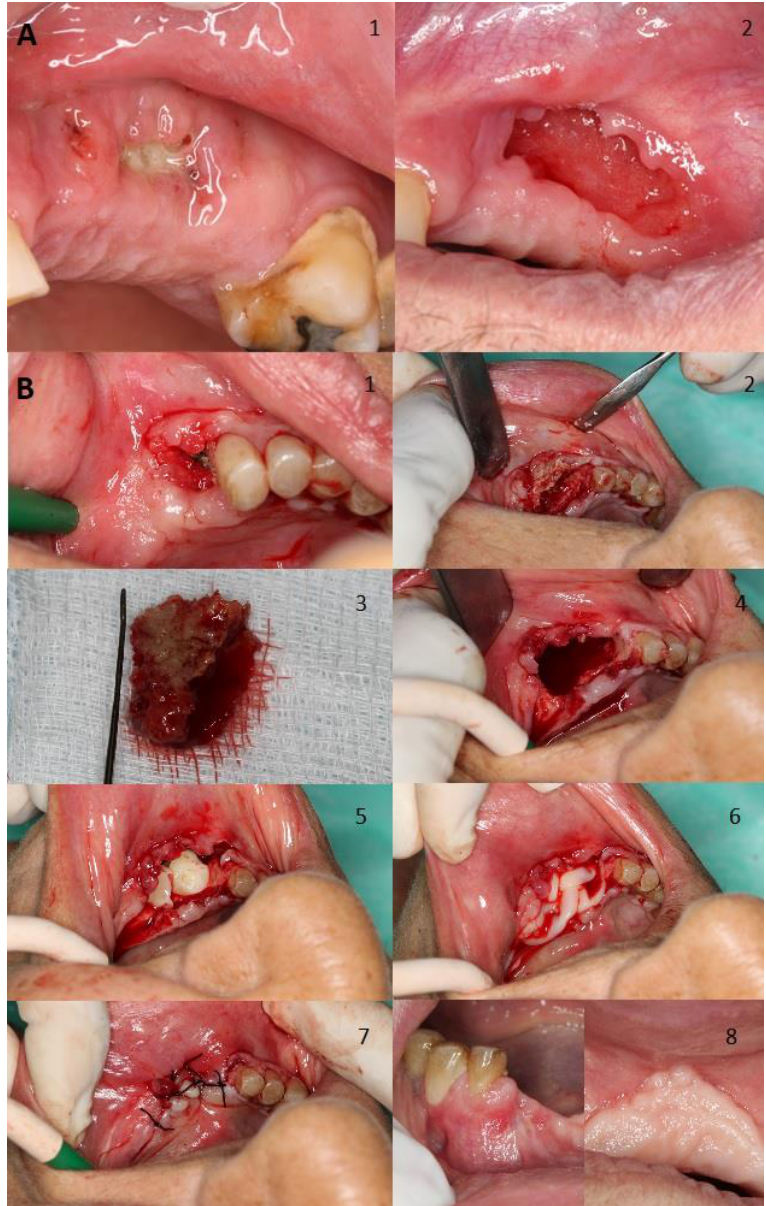
Figure 2. ( A ) Man aged 77 years with prostate cancer without symptomatology developed stage I MRONJ in his left maxilla with bone exposure after receiving zoledronate for suspected bone metastases. Image 1 relates to initial presentation, whilst the second one shows the outcome of treatment with antibiotics and chlorhexidine treatment for 2 months; bone gradually sequestered over time and the soft tissue as the soft tissue eventually closed. ( B ) Woman aged 81 years with osteoporosis who developed stage II MRONJ with bone exposure in her left mandible with severe pain. The patient was initially treated with risedronate but was eventually switched to denosumab. Triggers of necrosis were mainly severe chronic periodontal disease and a dental extraction (Image 1). Initially we performed an incision and flap elevation to visualize affected area (Image 2). Then resection of necrotic bone was performed (Images 3 and 4). Then, an application of L-PRF by Choukroun’s method was performed and primary wound closure was achieved (Image 5, 6, and 7). A month after treatment total resolution was achieved (Image 8).